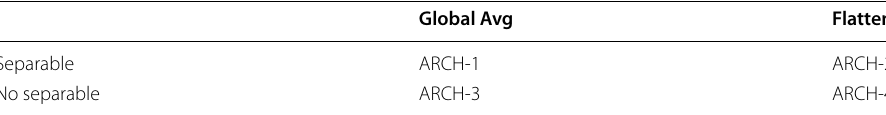
Table 5 Architectures setting Global Avg Flatten Separable ARCH-1 ARCH-2 No separable ARCH-3